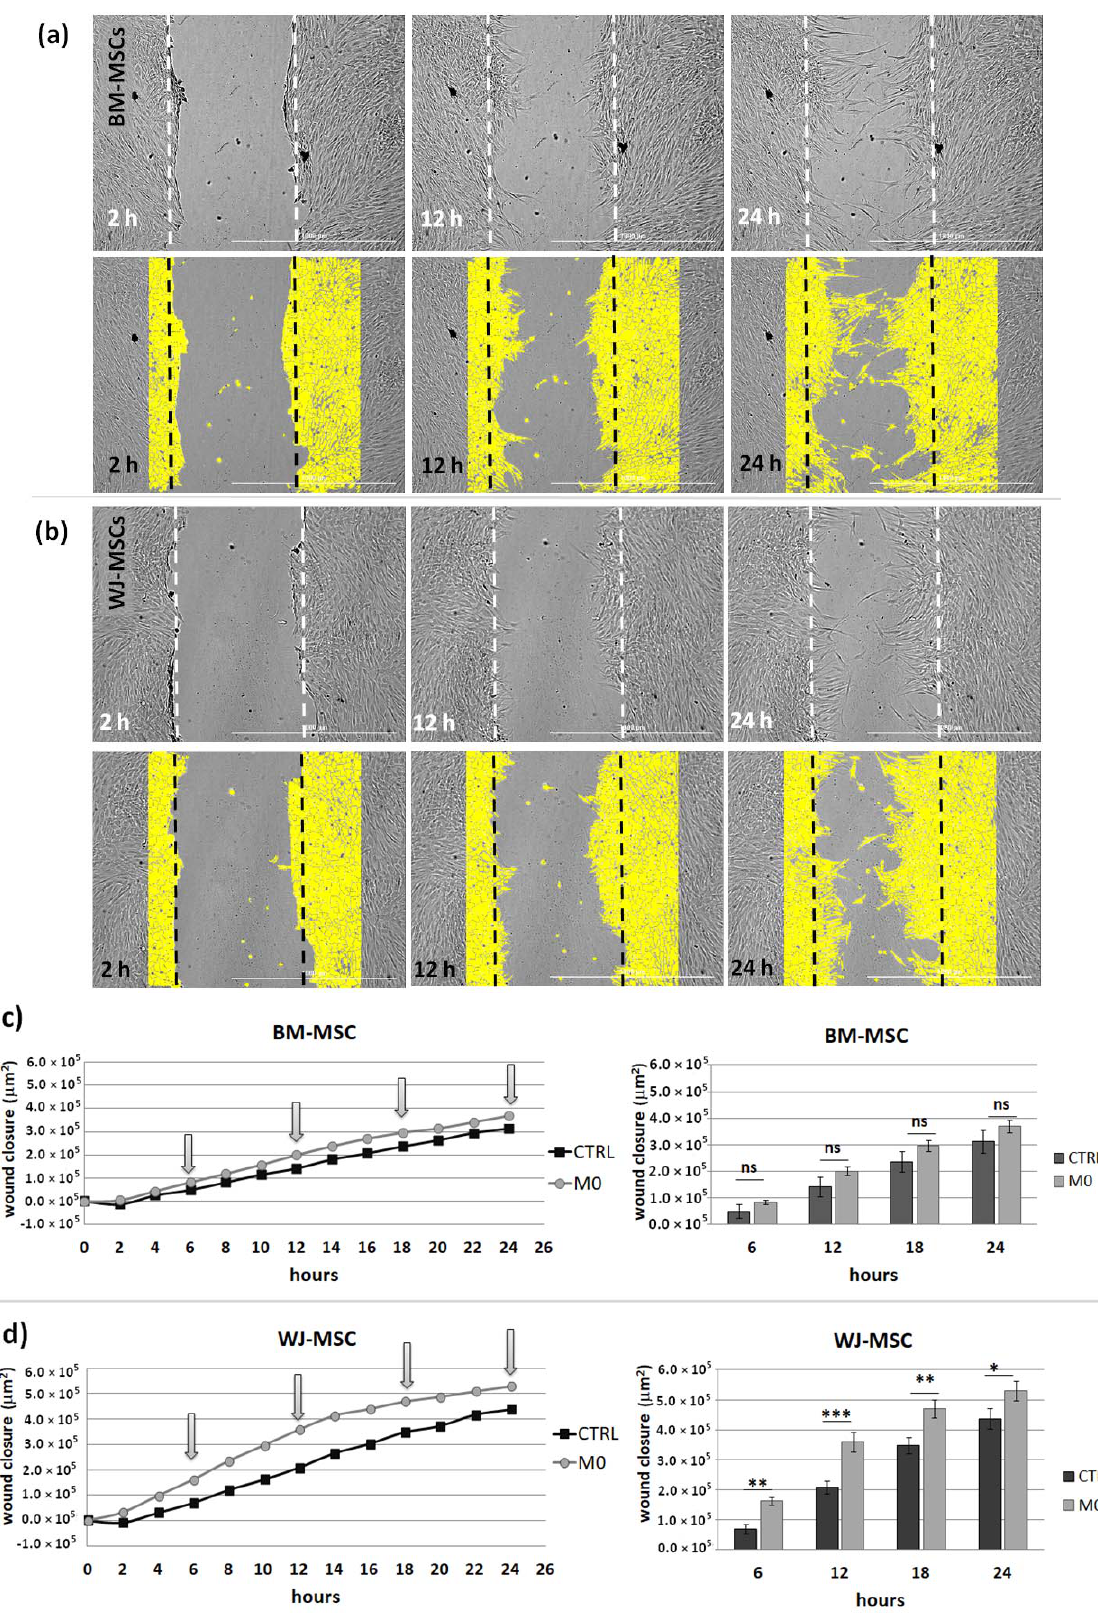
Figure 9. The effect of secretome from M0 macrophages on the mobility of human BM-MSCs and WJ-MSCs. The scratch assay. Images representing the behavior of mesenchymal stromal cells from ( a ) bone marrow and ( b ) Wharton’s jelly during a scratch test and the way of analysis. Upper row—pictures of the same field at different time points; lower row— pictures of the same fields of view with the area occupied by the migrating cells marked by the software (yellow color). The “wound” closure was documented every 2 h for 24 h, and statistical analysis was performed at 6, 12, 18, and 24 h time points (arrows online charts). Scratch covering presented in μ m 2 in time (h) in relation to the time point 0. The scale bar indicates 1000 μ m. Migration of BM-MSCs ( c ) and WJ-MSCs ( d ) analyzed in medium supplemented with 4% of FBS (CTRL) or in the presence of conditioned medium from M0 macrophages (M0). Bars represent mean values (± SEM). Data analyzed using Wilcoxon test or T-test for related data (depending on the data distribution, which was determined using Shapiro– Wilk test) * p < 0.05; ** p < 0.01; *** p < 0.001; ns—statistically not significant. Data collected during 3 independent experi- ments, MSCs from 3 different donors used for each MSC type, macrophages from 6 different donors used, n = 6. Figure 10. The effect of different subsets of macrophages on the mobility of human BM-MSCs ( a ) and WJ-MSCs ( b ). The scratch assay. The “wound” closure was documented every 2 h for 24 h, and statistical analysis was performed at 6, 12, 18, and 24 h time points. Scratch covering presented in μ m 2 in time (h) in relation to the time point 0. MSCs migrated in